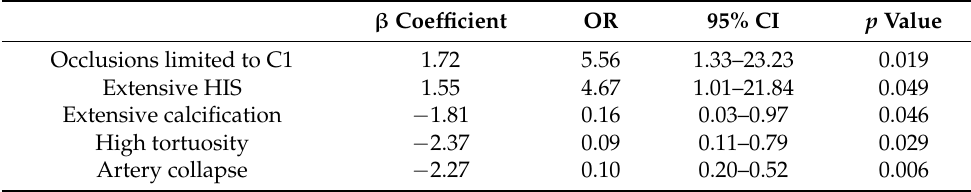
Table 3. Multivariate analysis of MR-VWI predictors of successful recanalization.